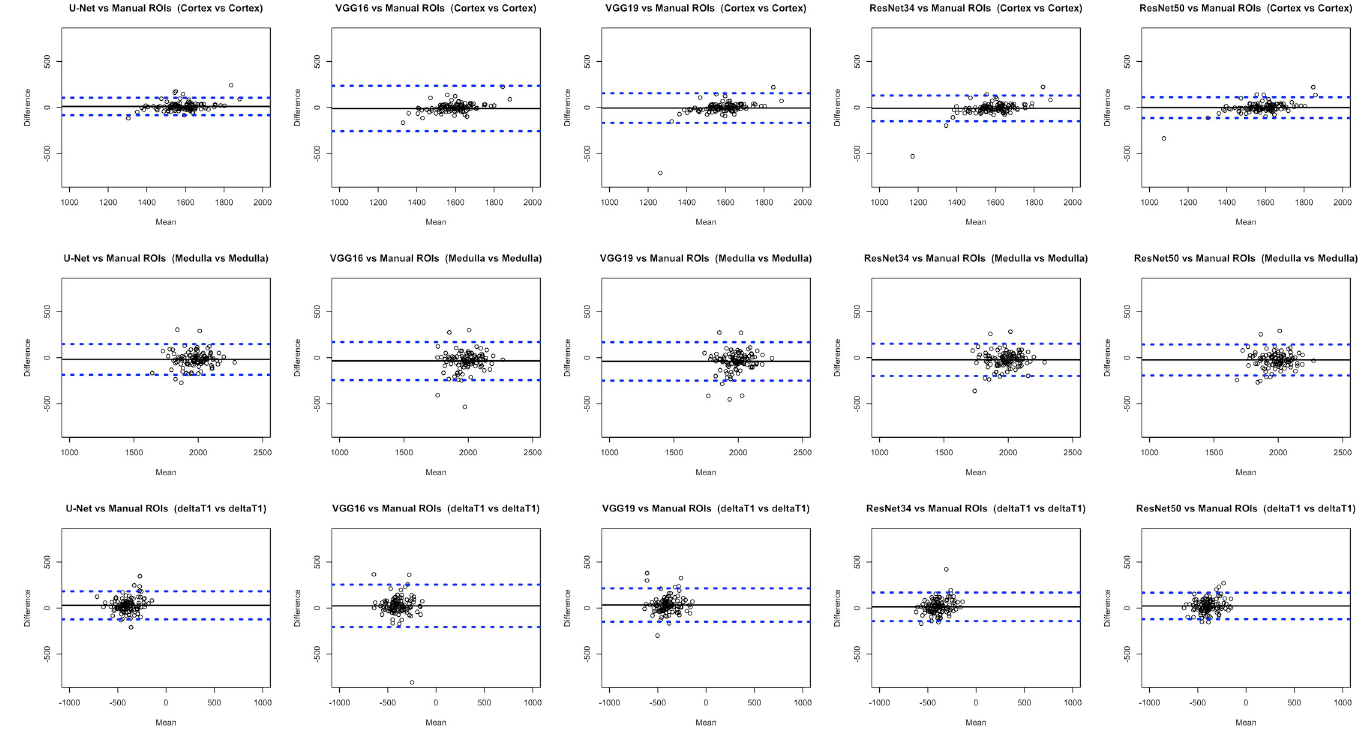
Fig 5. Bland-Altman (BA) plots between gold standard manual ROIs [4] and deep learning based cortico-medullary values. Top Row: BA plot of cortical T1 values; Middle Row: BA plot of medullary T1 values; Bottom Row: BA plot of cortico-medullary difference ( Δ T1) values.